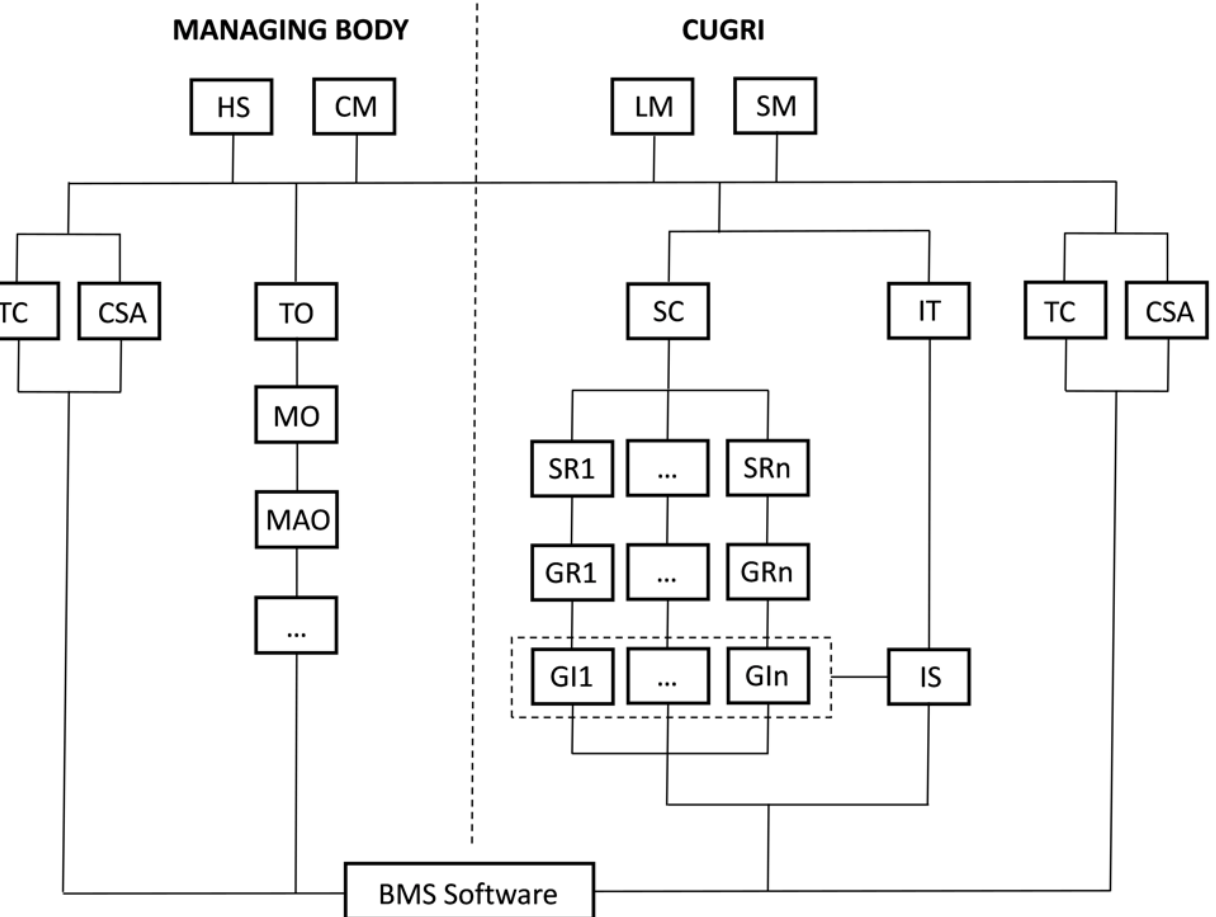
Figure 5. Operating model flow chart (for codes see text).